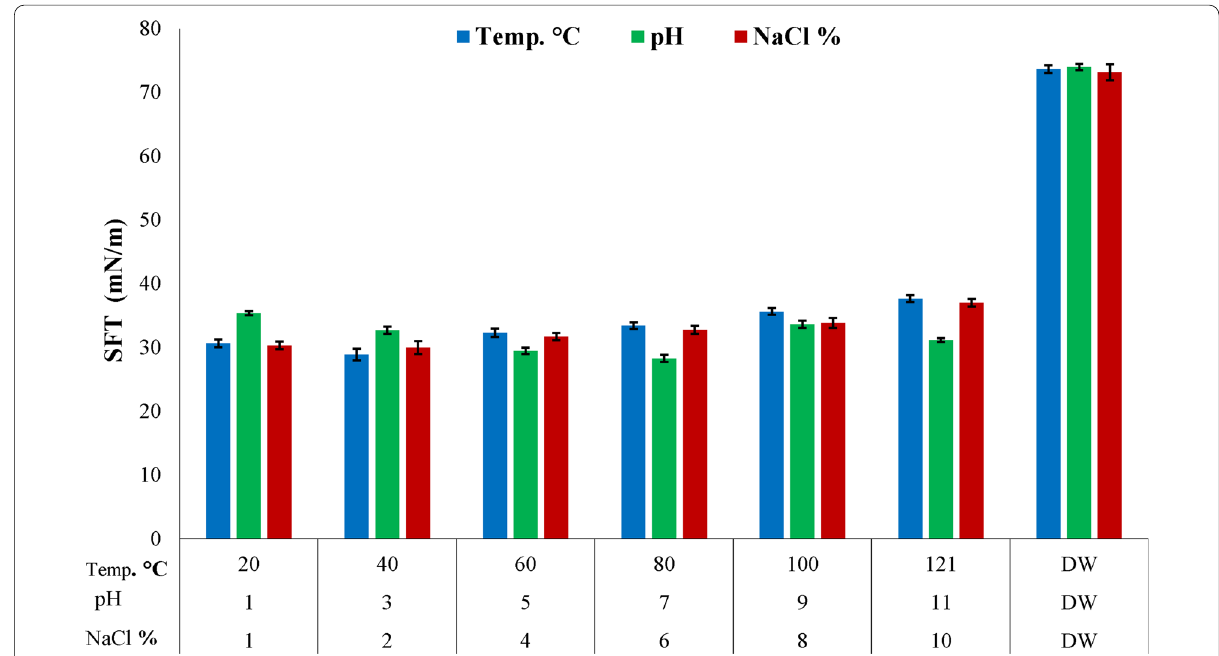
Fig. 4 Stability of crude lipopeptide extract against various environmental factors like temperature ranges 20–121 °C, NaCl conc. 1–10% (w/v) and pH ranges 1–11. DW distilled water, Temp temperature, NaCl sodium